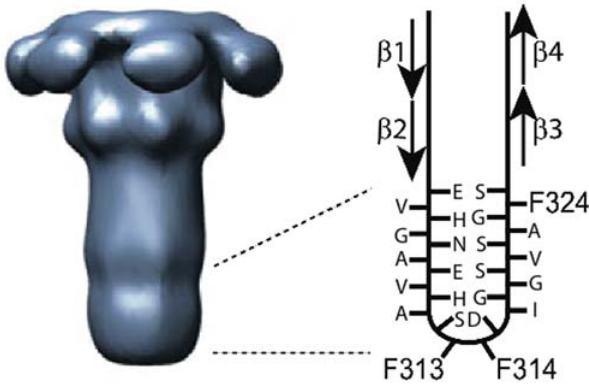
Figure 1. Locations of F313, F314, F324 and b strands 1–4 in the b barrel and the pore. The approximate boundaries of the membrane-spanning region are indicated by the dashed lines. The illustration of the pore structure (left), reconstructed from single-pore images obtained by electron microscopy, is modified from Figure 4 of reference [4]. The amino acid sequence of the H hairpin is as follows: E(302)VHGNAEVHAS FF DIGGSVSAG F S(325).